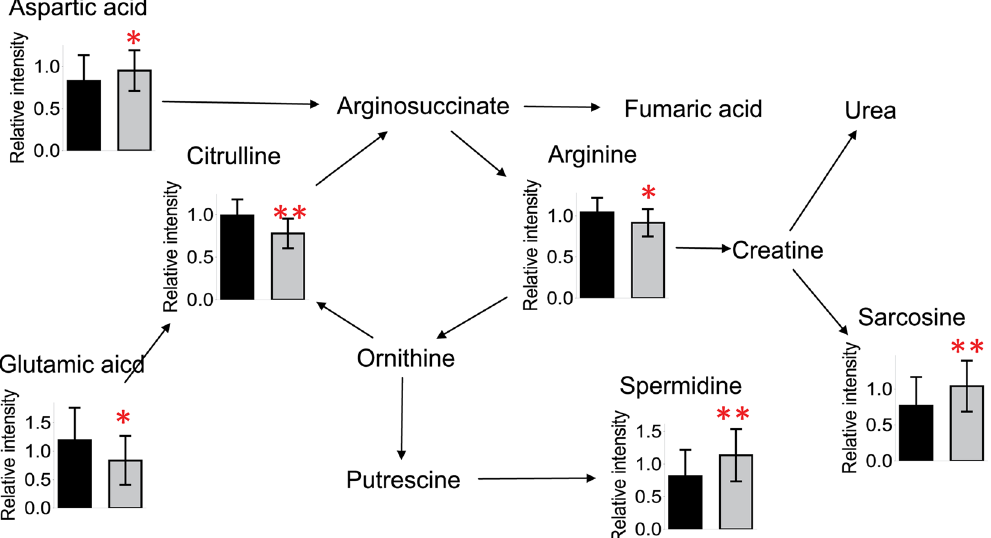
Figure 4. Mapping of differential metabolites related to arginine and proline metabolism. Data shown as mean ± SEM. * < 0.05, ** < 0.01.